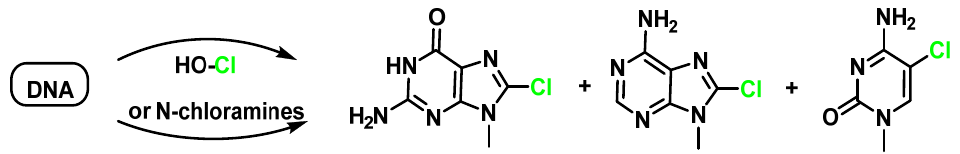
Figure 46. Formation of 8-chloro-2 ′ -deoxyguanosine, 8-chloro-2 ′ -deoxyadenosine, and 5-chloro-2 ′ - deoxycytidine by the reaction of DNA with HOCl or N -chloramines. A possible mechanism of formation of 8-chloro-9-methyl-9H-purin-6-amine from the